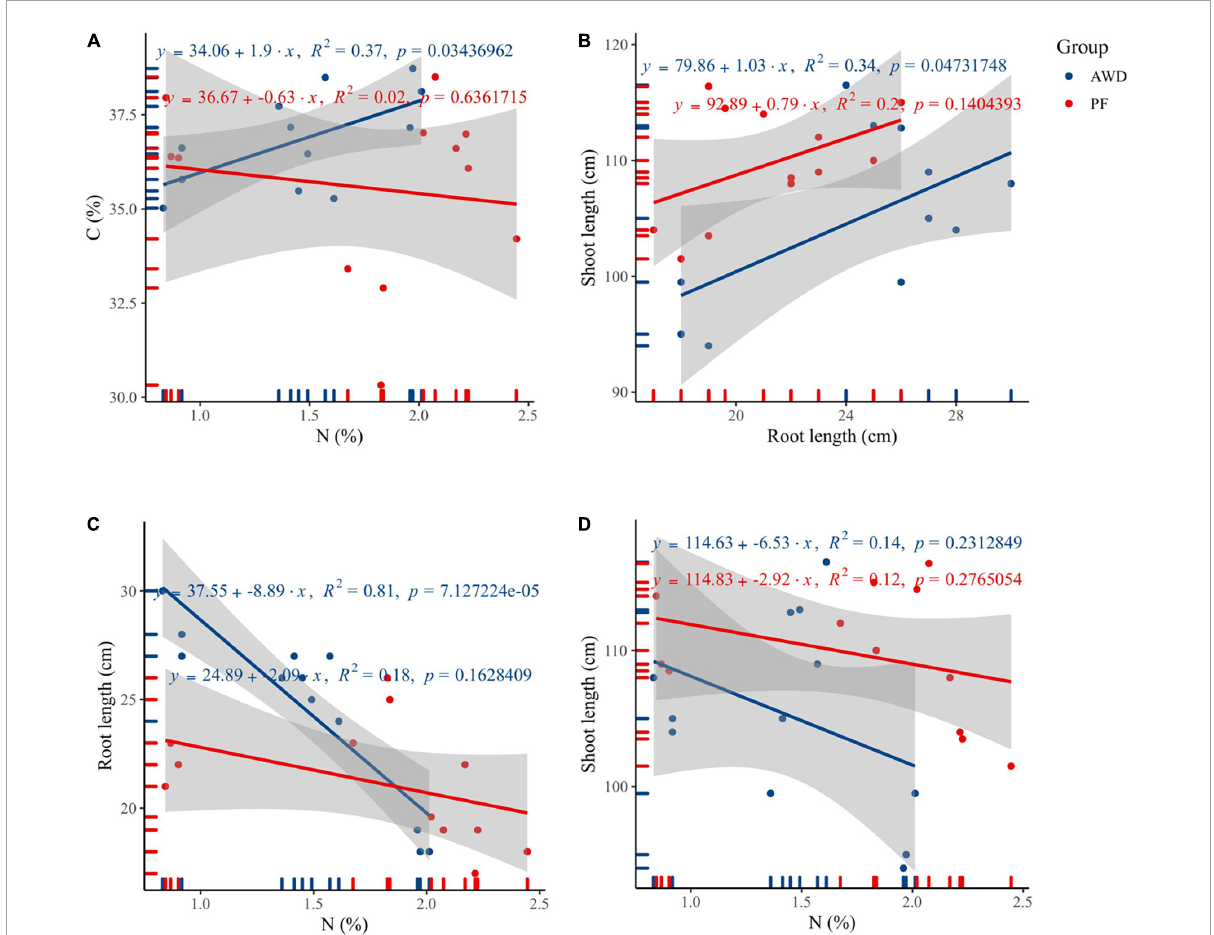
FIGURE2 Correlation between (A) C and N, (B) shoot length and root length, (C) root length and nitrogen, and (D) shoot length and nitrogen during alternate wetting and drying (AWD) and permanent flooding